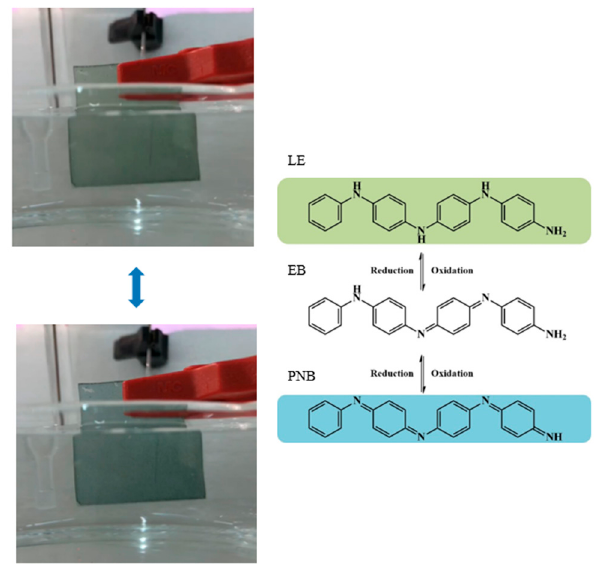
Figure 9. Effect of applied voltage on the color of PANI/SF mats. (Top: 0.2 V; bottom: 0.6 V).